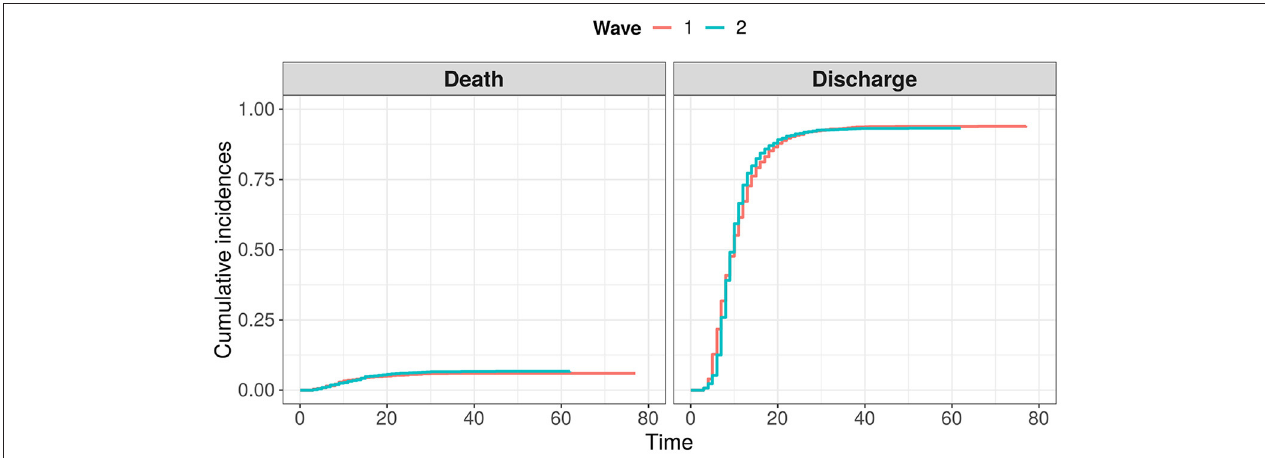
FIGURE 2 | Comparison of cumulative distribution functions for events “death” and “discharge” between two waves of COVID-19.